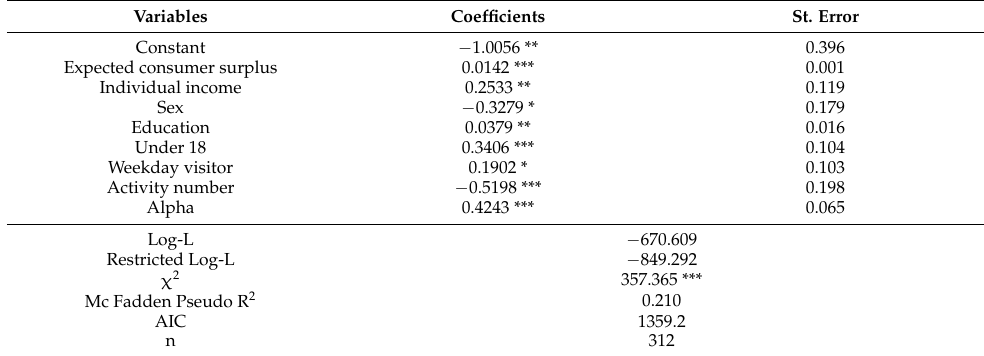
Table 3. Trip demand model.